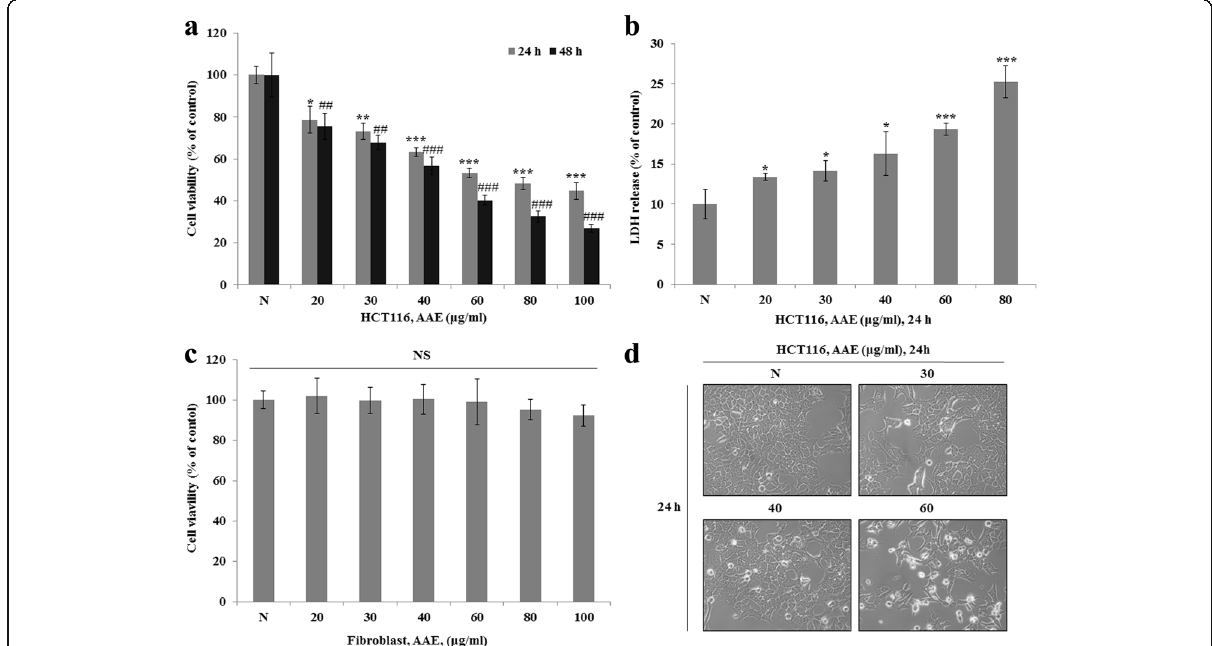
Fig. 1 AAE reduces cell proliferation in HCT116 colon cancer cells. a , c Cell viability was measured by MTT assay. a is HCT116 cell line. c is Fibroblast cell line. The statistical analysis of the data was carried out by use of an T-test. */#p < 0.05, **/##'p < 0.01 and ***/###p < 0.001 (each experiment, n = 3). b LDH assay was performed for assessing cell deaths. Cytotoxicity was induced by AAE. The statistical analysis of the data was carried out by use of an T-test. *p < 0.05, **p < 0.01 and ***p < 0.001 (each experiment, n = 3). d AAE affects the morphology of HCT116 cells, and promotes cell death in a dose-dependent manner. HCT116 were treated with AAE (0, 30, 40, and 60 ìg/ml) for 24